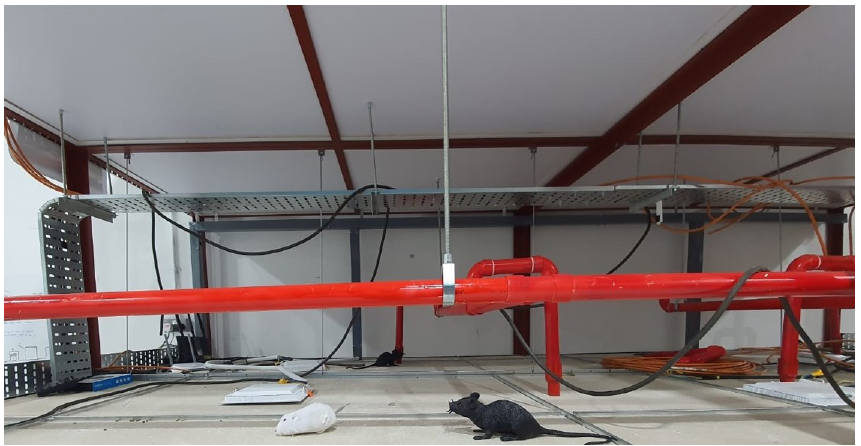
Figure 7. False ceiling prototype